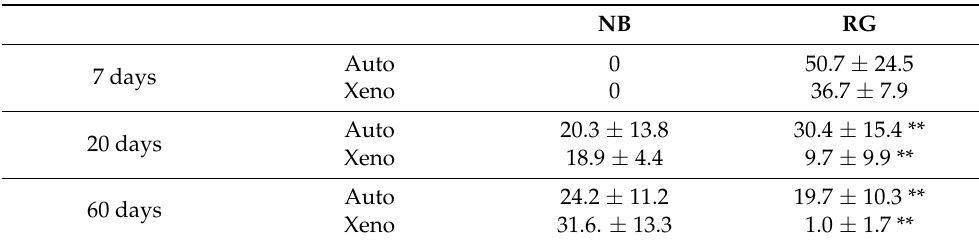
Figure 6. Graph illustrating the percentages of new bone and residual grafts in the xenogenous (test) and autogenous (control) groups after 7, 20 and 60 days of healing. * p < 0.05 inter-group analysis. Table 2. Percentages of new bone and residual grafts obtained from the histomorphometric analysis of the evaluated periods.